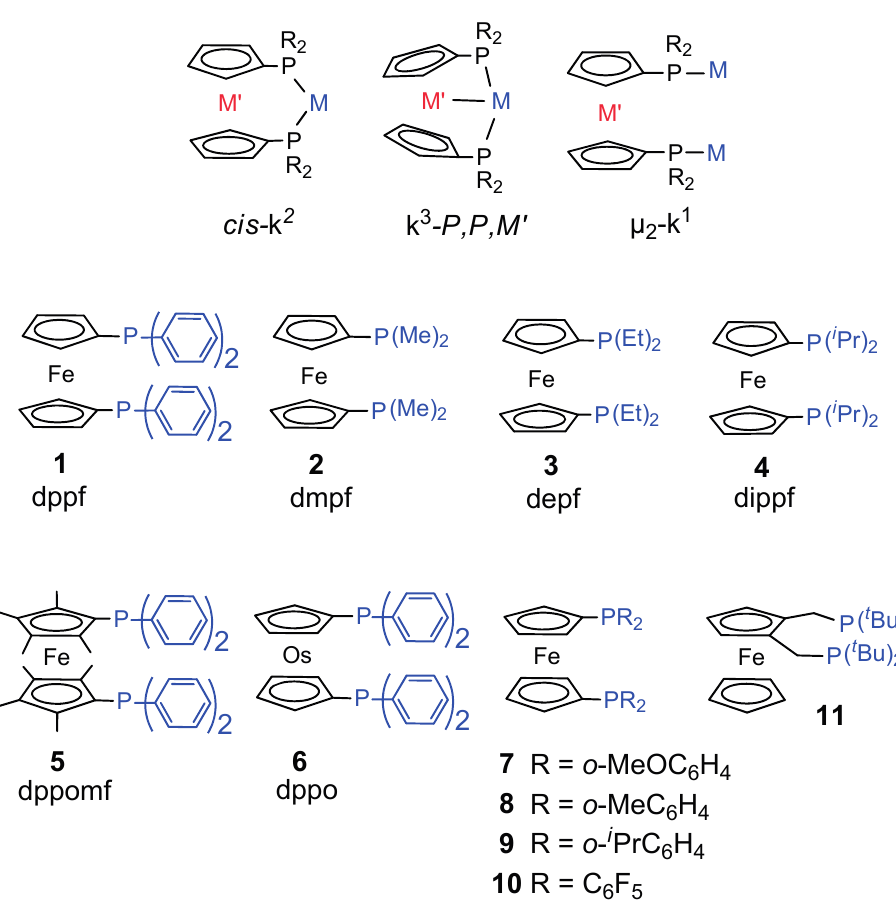
Figure 2. Metallocene-coordination modes and